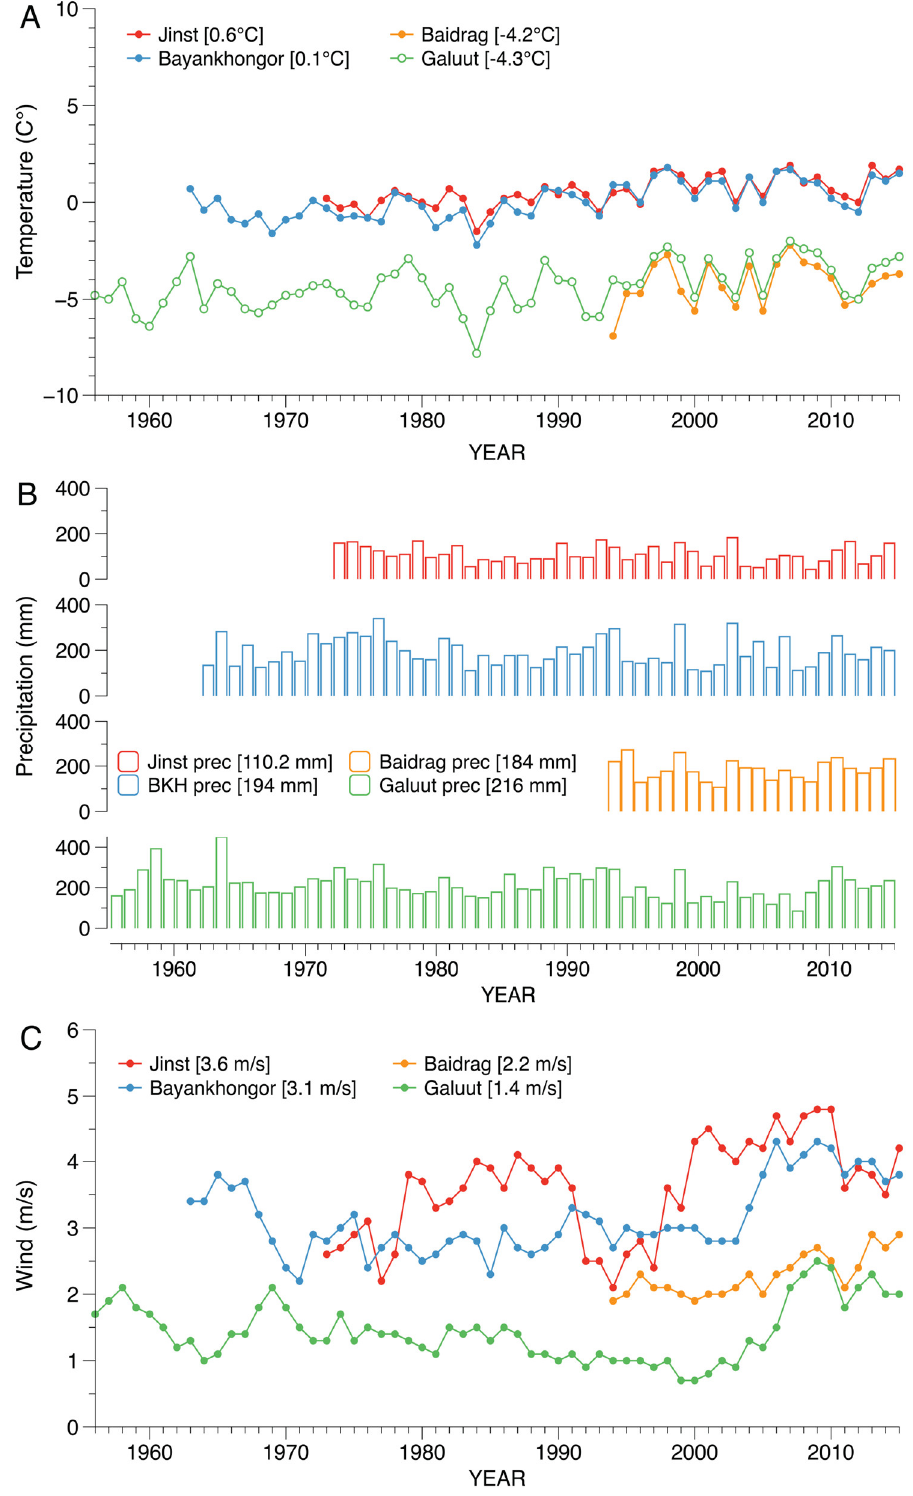
Figure 2. Meteorological data from the Jinst station (1973–2014), Bayankhongor (BKH) station (1963–2014), Galuut station (1956–2014), and Baidrag station (1994–2014). ( A ) Mean annual temperature; ( B ) annual precipitation; ( C ) mean annual wind speed (data from the National Agency for Meteorology and the Environmental Monitoring, Mongolia). Numbers in bracket are the averaged values.